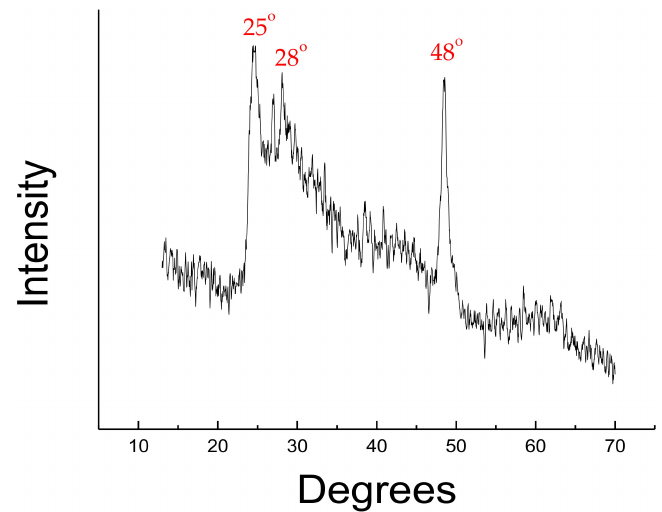
Figure 2. X-ray diffraction pattern of titanium dioxide nanotubes (TNT).